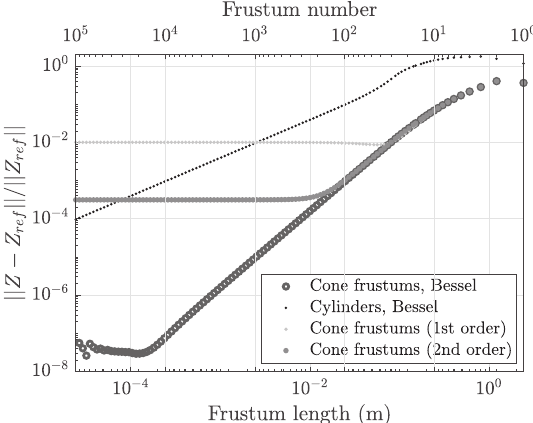
Figure 2. Reference input impedance of the simpli fi ed bassoon Figure 3. Evolution of the norm of the relative difference with computed by a division in 10 5 conical frustums with ZK-losses the reference impedance Z ref (10 5 conical frustums with Bessel (Bessel) computed with equations (23) and (24) for the functions) versus the length of each frustum for different equivalent radius R eq of each conical frustum of equation approximations (cylinders with Bessel functions, conical frus- n tums with Bessel functions, 1st or 2nd order approximation of losses).